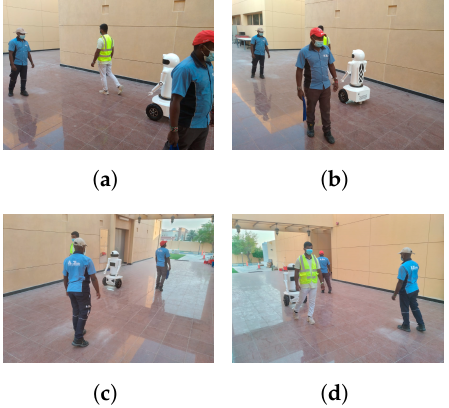
Figure 31. Following a human in crowded areas. ( a – d ) different